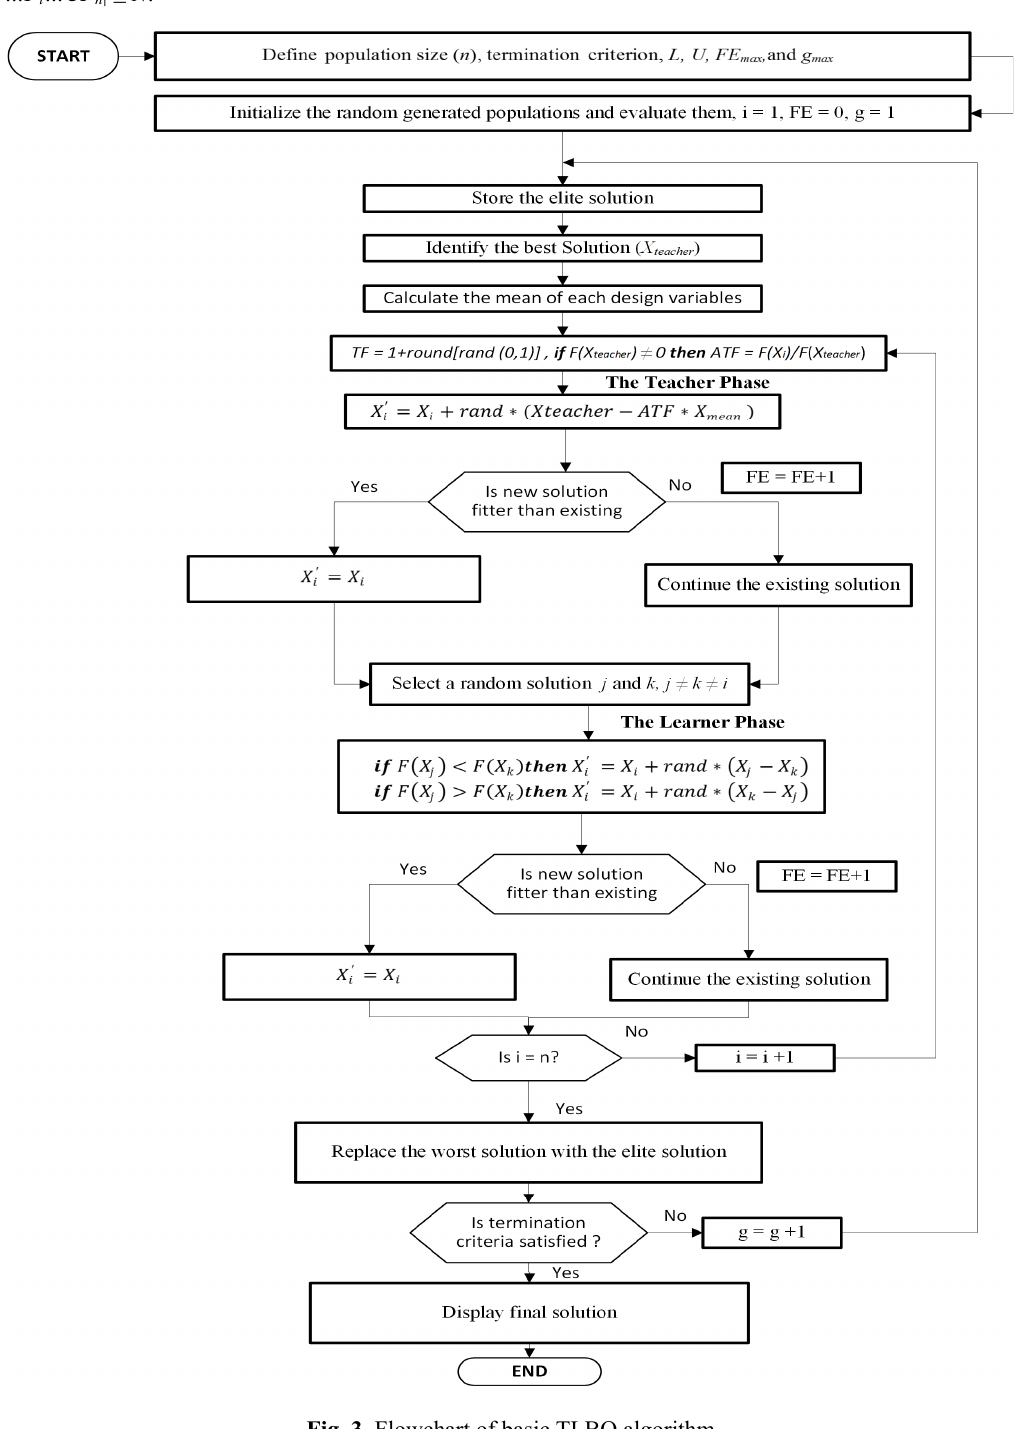
Fig. 3. Flowchart of basic TLBO